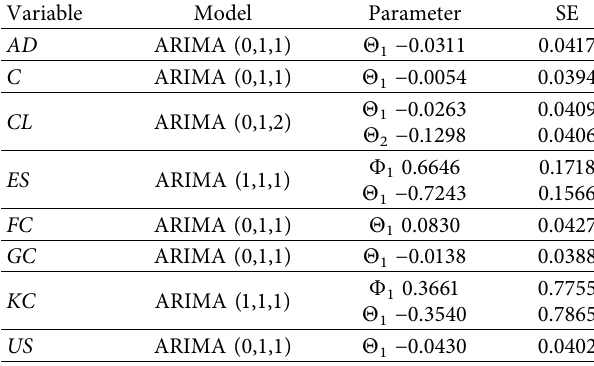
Table 3: AIC values of suggested ARIMA models. Table 4: Parameters estimation ML method for ARIMA models.